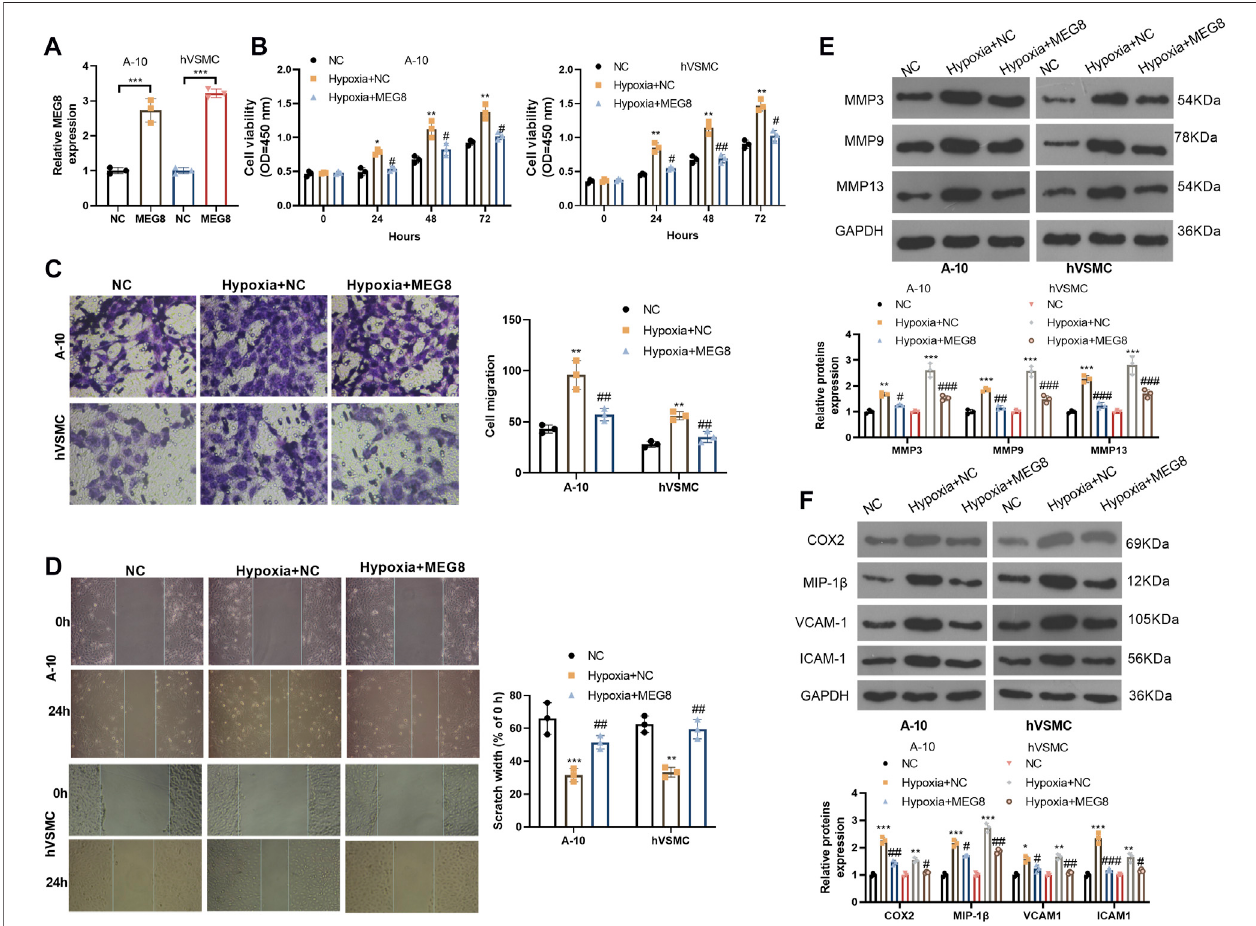
FIGURE 2 | Over-expression of MEG8 attenuated hypoxia-induced VSMC proliferation, in fl ammation and migration.MEG8 overexpressing plasmids were transfected in A-10 cells or hVSMCs, which were then induced with hypoxia. (A) The MEG8 overexpression model was established, and the MEG8 level was detected by qRT-PCR. (B) Cell proliferation was veri fi ed by the CCK-8 assay. (C) Cell migration was determined by the Transwell assay. (D) Wound healing assay was employed to analyze cell migration. (E) The protein expression of MMP3, MMP9 and MMP13 in A-10 cells or hVSMCs was compared by Western blot. (F) The pro fi les of COX2, MIP-1 β , VCAM-1 and ICAM-1 in A-10 cells or hVSMCs were checked by Western blot. * p < 0.05, ** p < 0.01, *** p < 0.001 (vs.NC group), # p < 0.05, ## p < 0.01, ### p < 0.001 (vs. hypoxia+NC group). All experiments were repeated three times, and each time was performed in